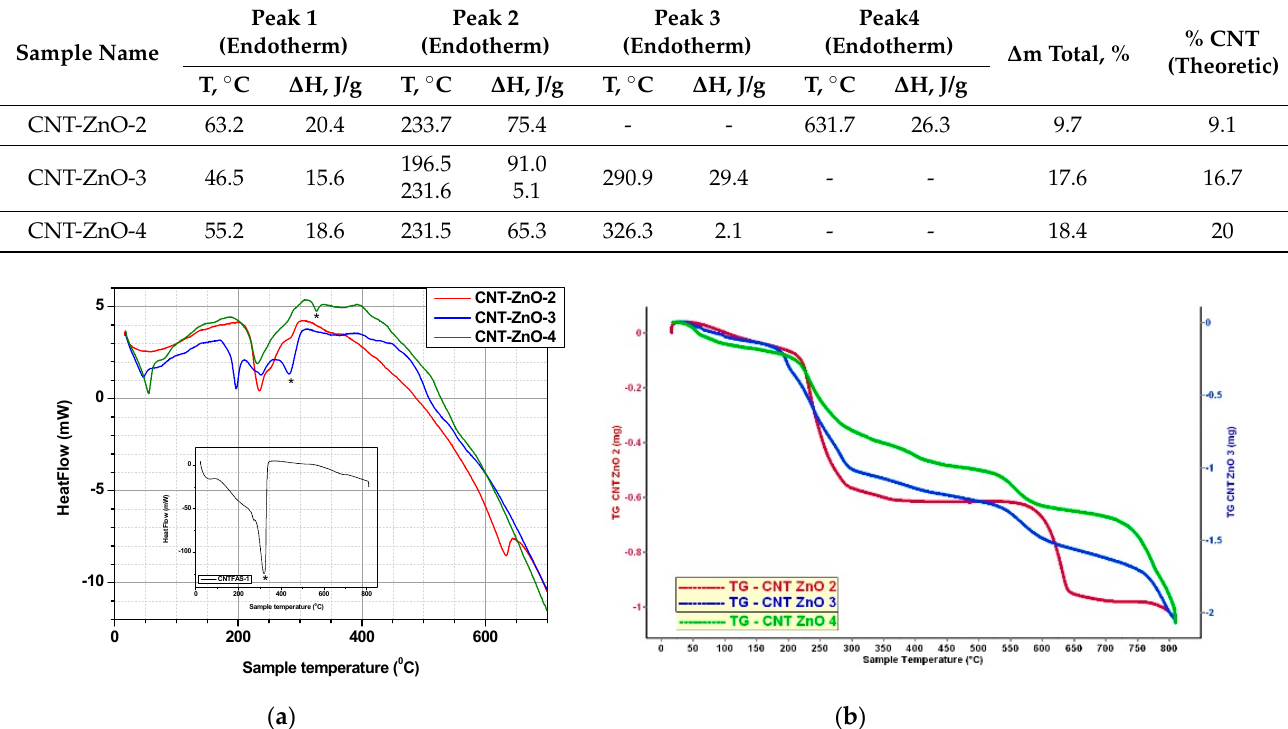
Figure 6. ( a ) DSC-TG curves for: CNT-ZnO samples versus CNTFAS-1 sample (acid mixture 4 M:10 M). CNT:ZnO weight Figure 6. a) DSC-TG curves for: CNT-ZnO samples versus CNTFAS-1 sample (acid mixture 4M: ratio for CNT-ZnO-2 = 1:10; for CNT-ZnO-3 = 1:5 and respectively for CNT-ZnO-4 = 1:4; Inset shows DSC curve of CNTFAS-1 10M). CNT:ZnO weight ratio for CNT-ZnO-2=1:10; for CNT-ZnO-3=1:5 and respectively for CNT- sample (acid mixture 4 M:10 M); ( b ) TG curves forCNT-ZnO-2,CNT-ZnO-3 and CNTZnO-4 ZnO-4=1:4; Inset shows DSC curve of CNTFAS-1 sample (acid mixture 4M: 10M) ; b) TG curves